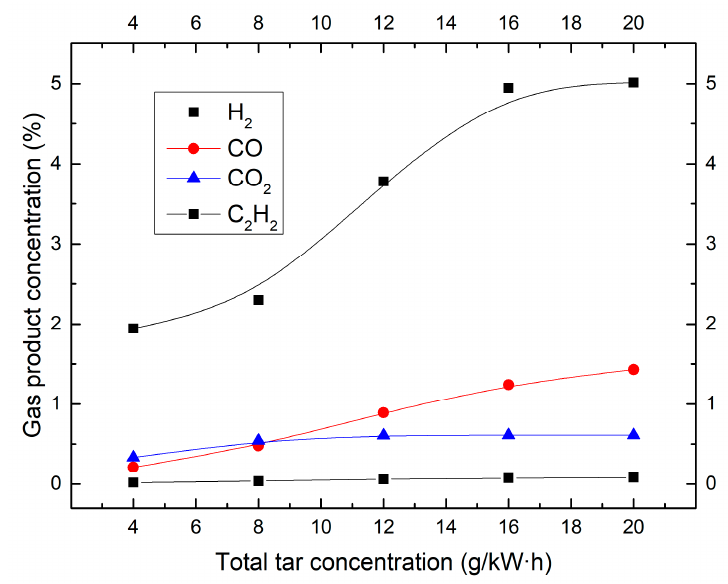
Figure 4. Effect of tar concentration on the composition of the off-gas.